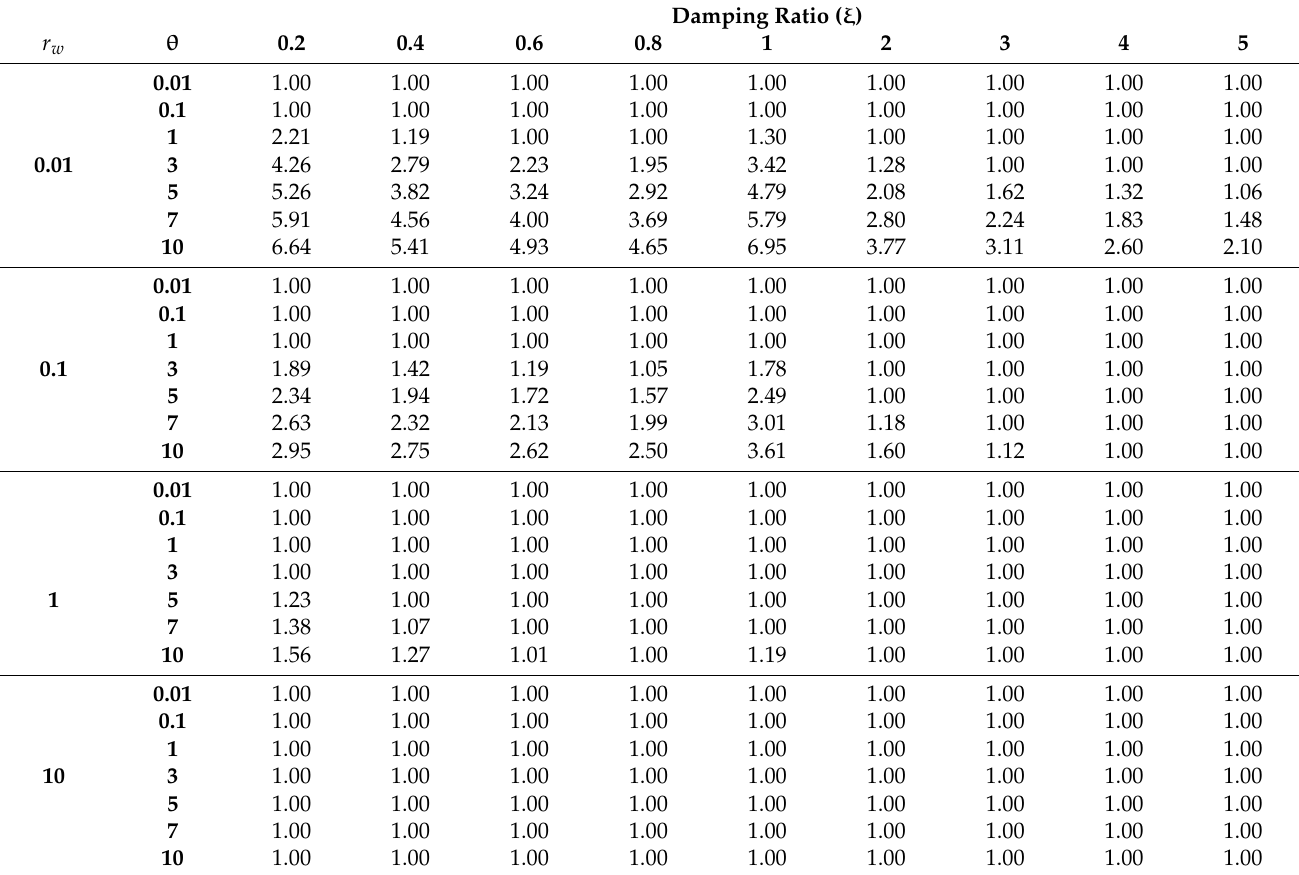
Table 3. Normalized TV for MPC (Process 1, setpoint response).